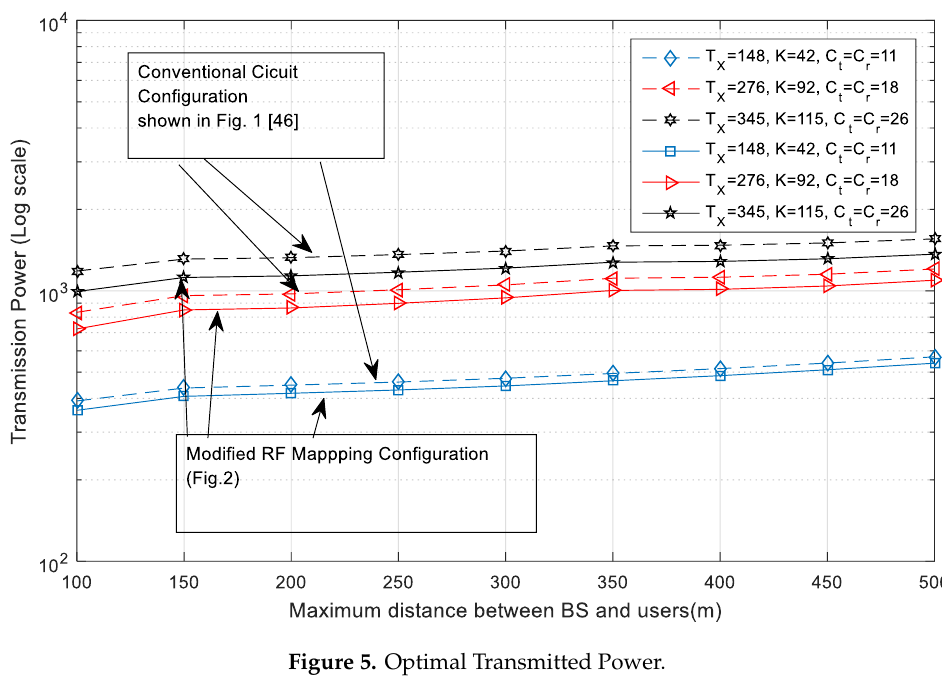
Figure 5. Optimal Transmitted Power. Energies 2019 , 12 , x FOR PEER REVIEW 21 of 25